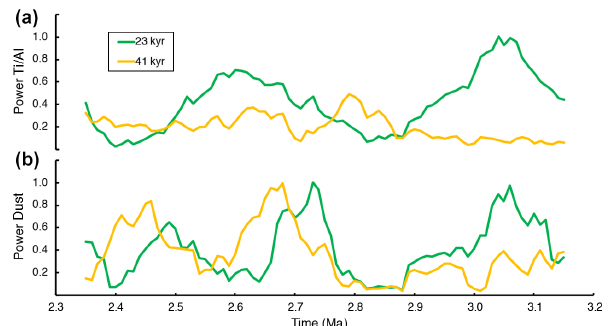
Figure 9. Evolutive normalised power spectrum for (a) Ti / Al of Site 967 and (b) dust of Site 659 for 23kyr (green) and 41kyr (yel- low) using a time window of